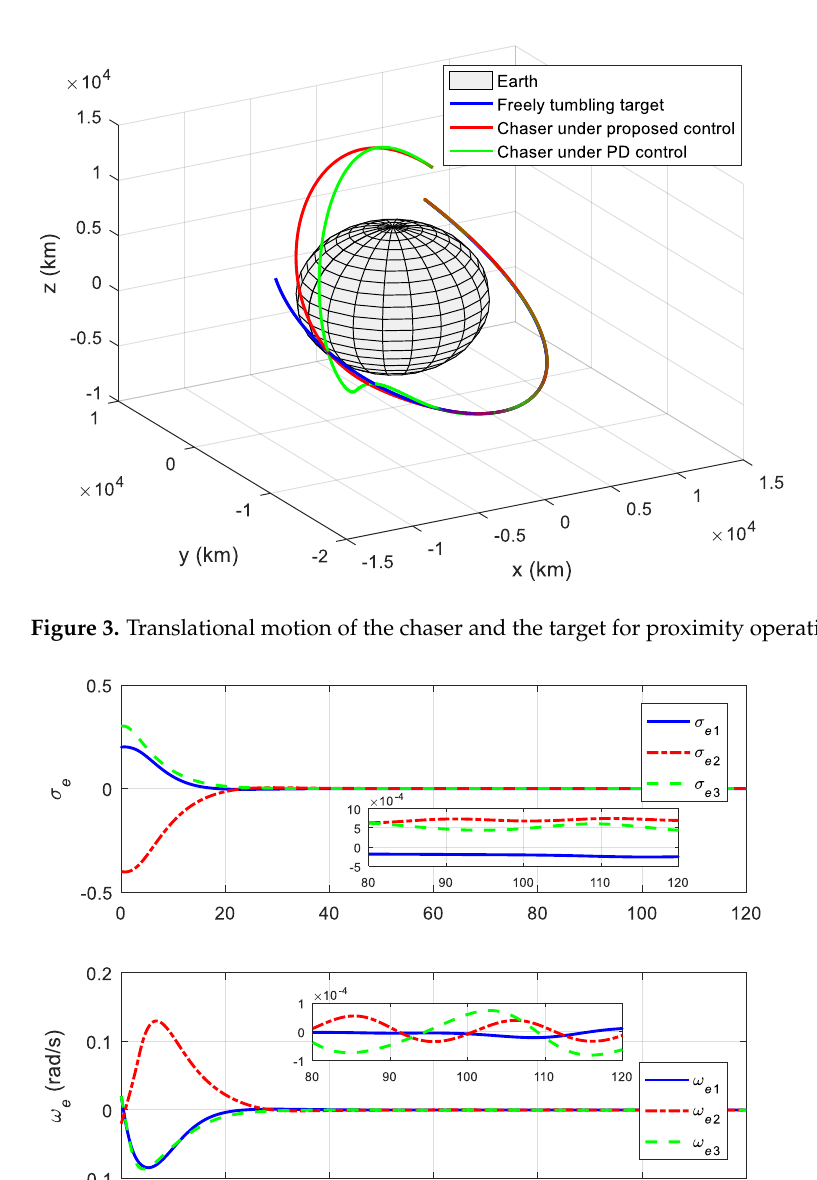
Figure 5. Relative position and velocity under the proposed controller. Figure 6. Control torques and forces of the chaser under the proposed controller.